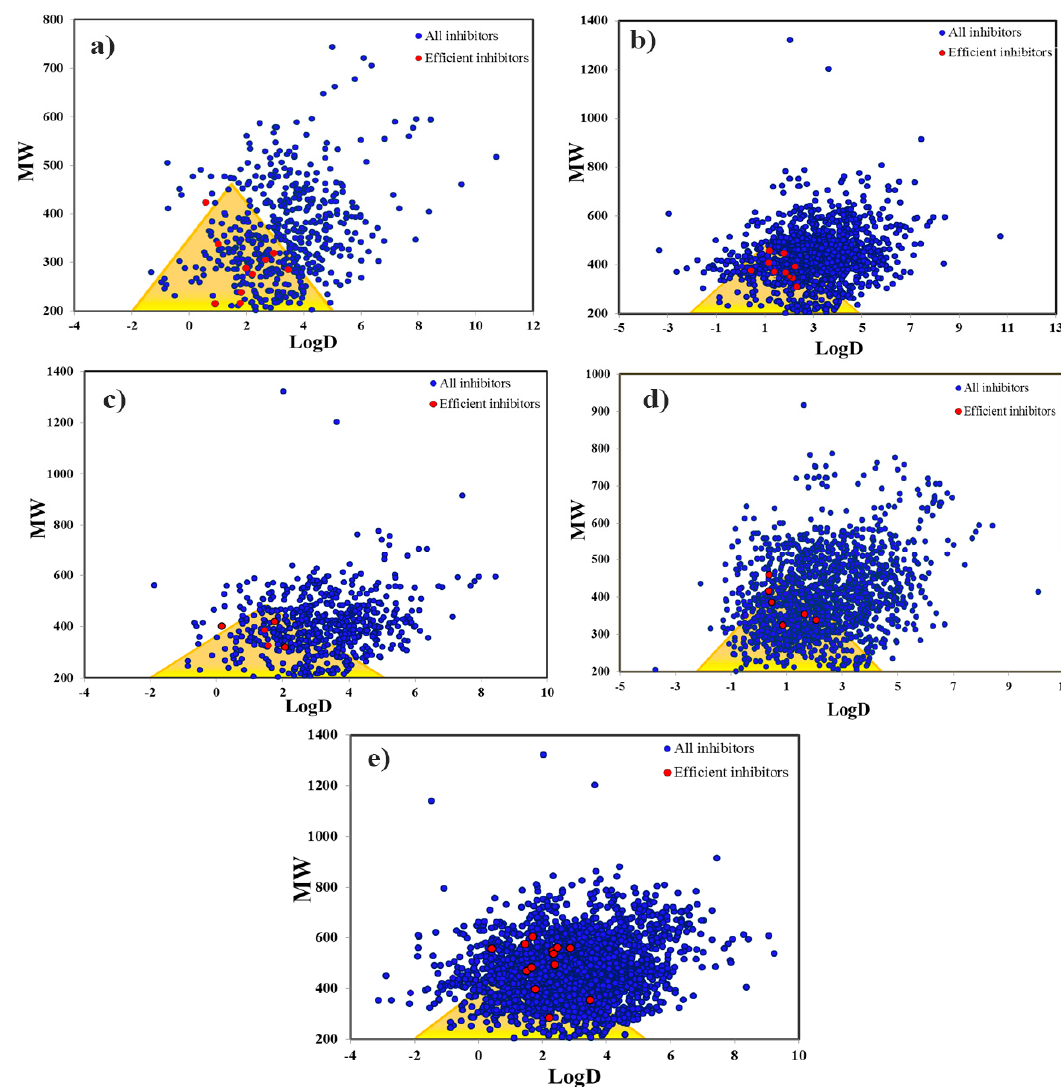
Figure 7. Golden Triangle rule positioning of ( a ) CYP1A2 inhibitors, ( b ) CYP2C9 inhibitors, ( c ) CYP2C19 inhibitors, ( d ) CYP2D6 inhibitors and ( e ) CYP3A4 inhibitors. Here, all compounds are denoted by blue points, whereas highly e ffi cient inhibitors are shown by red points. The compounds located